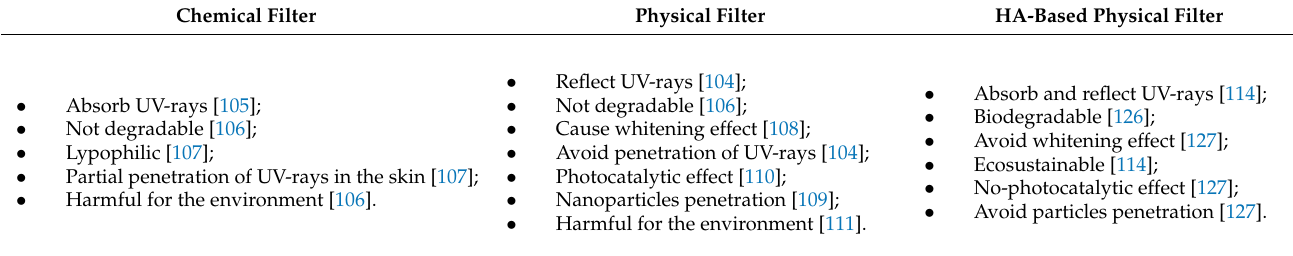
Table 3. Differences between chemical, physical and hydroxyapatite (HA)-based physical filters. Chemical